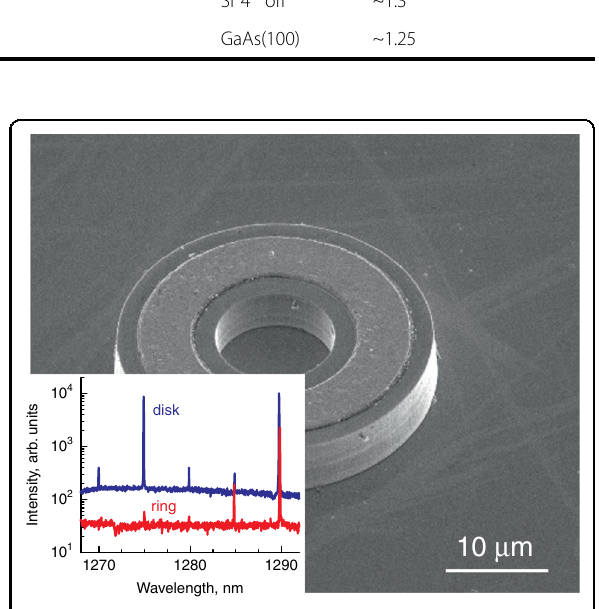
Fig. 2 Microring laser. Main panel: SEM image of QD-on-GaAs microring. Inset: comparison of emission spectra of microdisk (upper curve) and microring (lower curve) made of the same